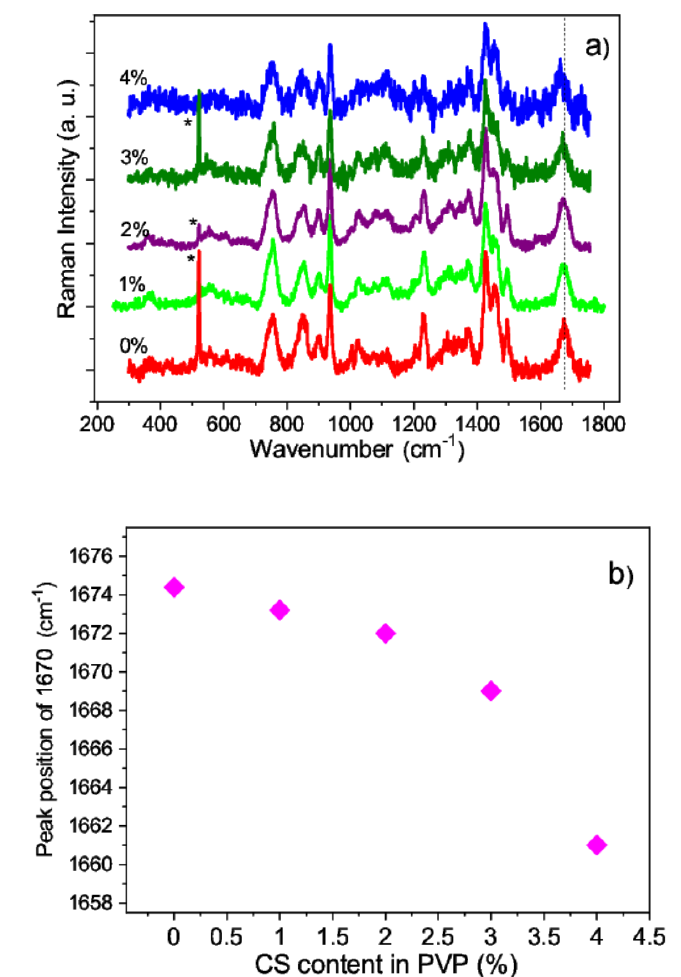
Figure 3. ( a ) Raman spectra of x%CS/6%PVP composites with × values (in percentage) shown beside each of the curves. ( b ) The dependence of C=O band position, obtained after band fitting, vs. CS content. Peak at 520 cm −1 in ( a ) marked by asterisk is attributed to Si wafer.